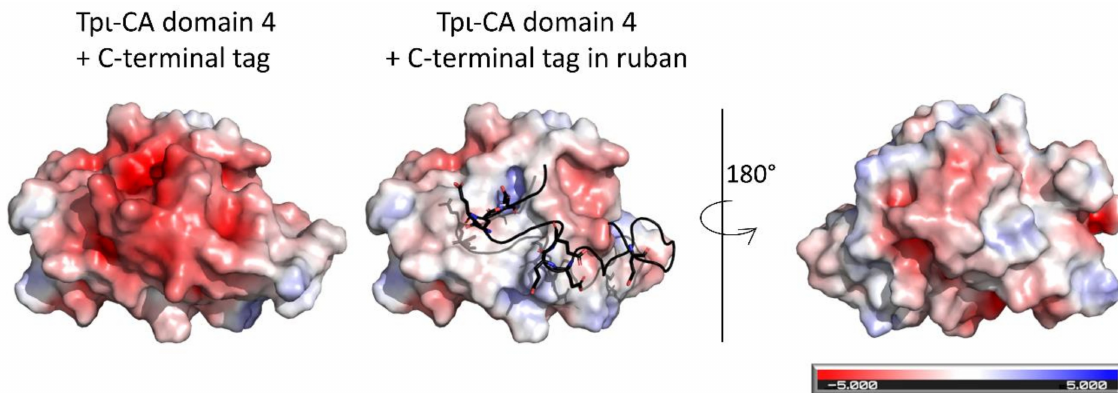
Figure 9. Electrostatic surface of the tp ι -CA domain 4 with the C-terminal extension ( left ) or without ( right ). The C-terminal extension is represented in cartoon with the Glu residues in stick. The color of the surface corresponds to the electrostatic charge, which ranges from − 5 (red) to +5